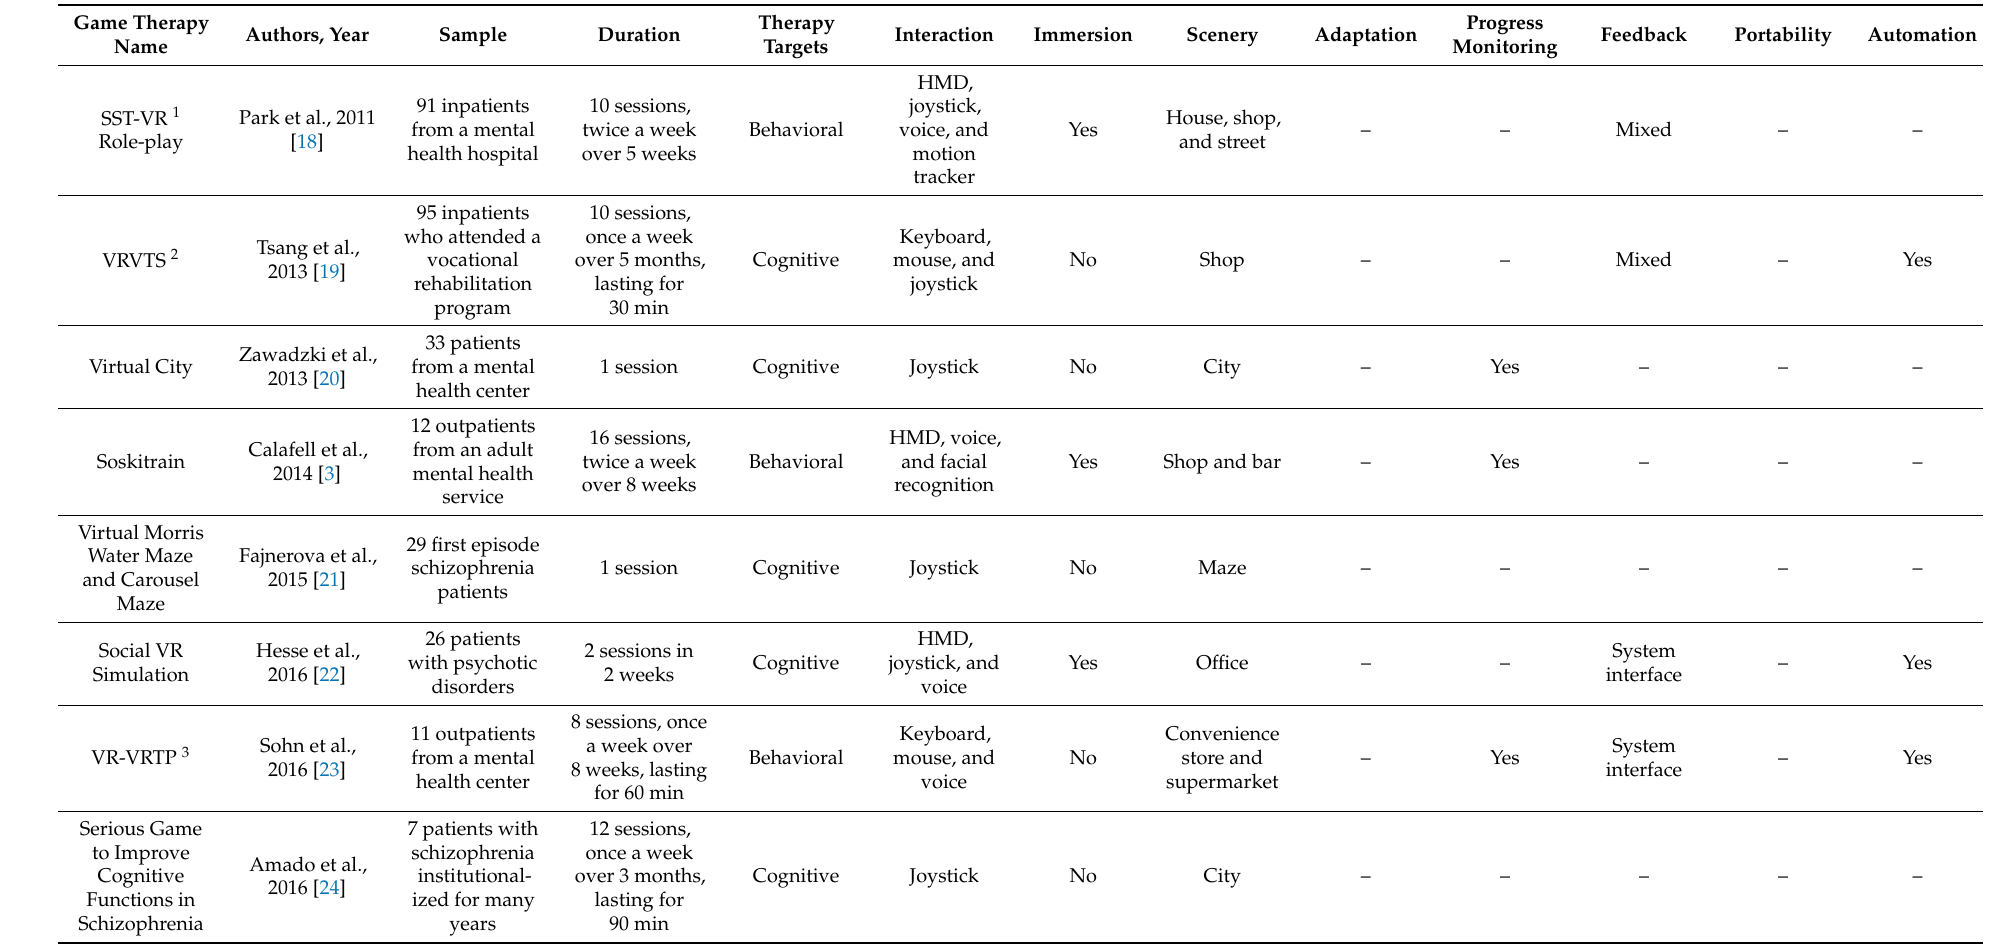
Table 1. The selected VR therapies